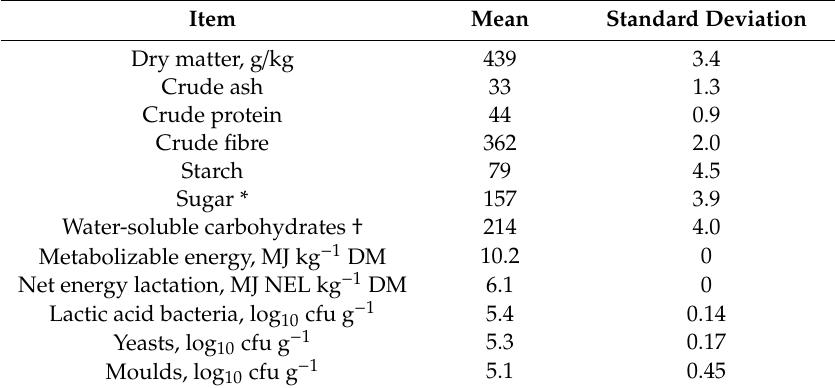
Table 1. Composition of whole-crop rye before the additive application ( n = 3, data given in g kg − 1 dry matter (DM) unless stated